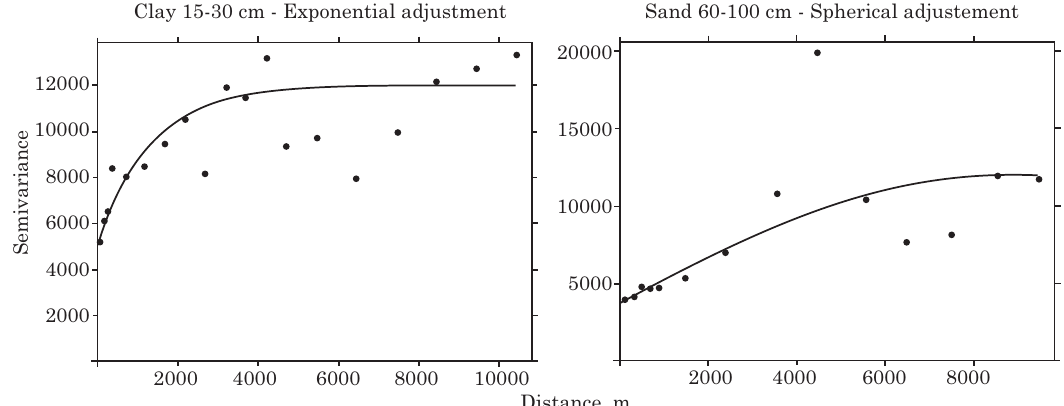
Figure 4.Adjustment of variograms for clay and sand.